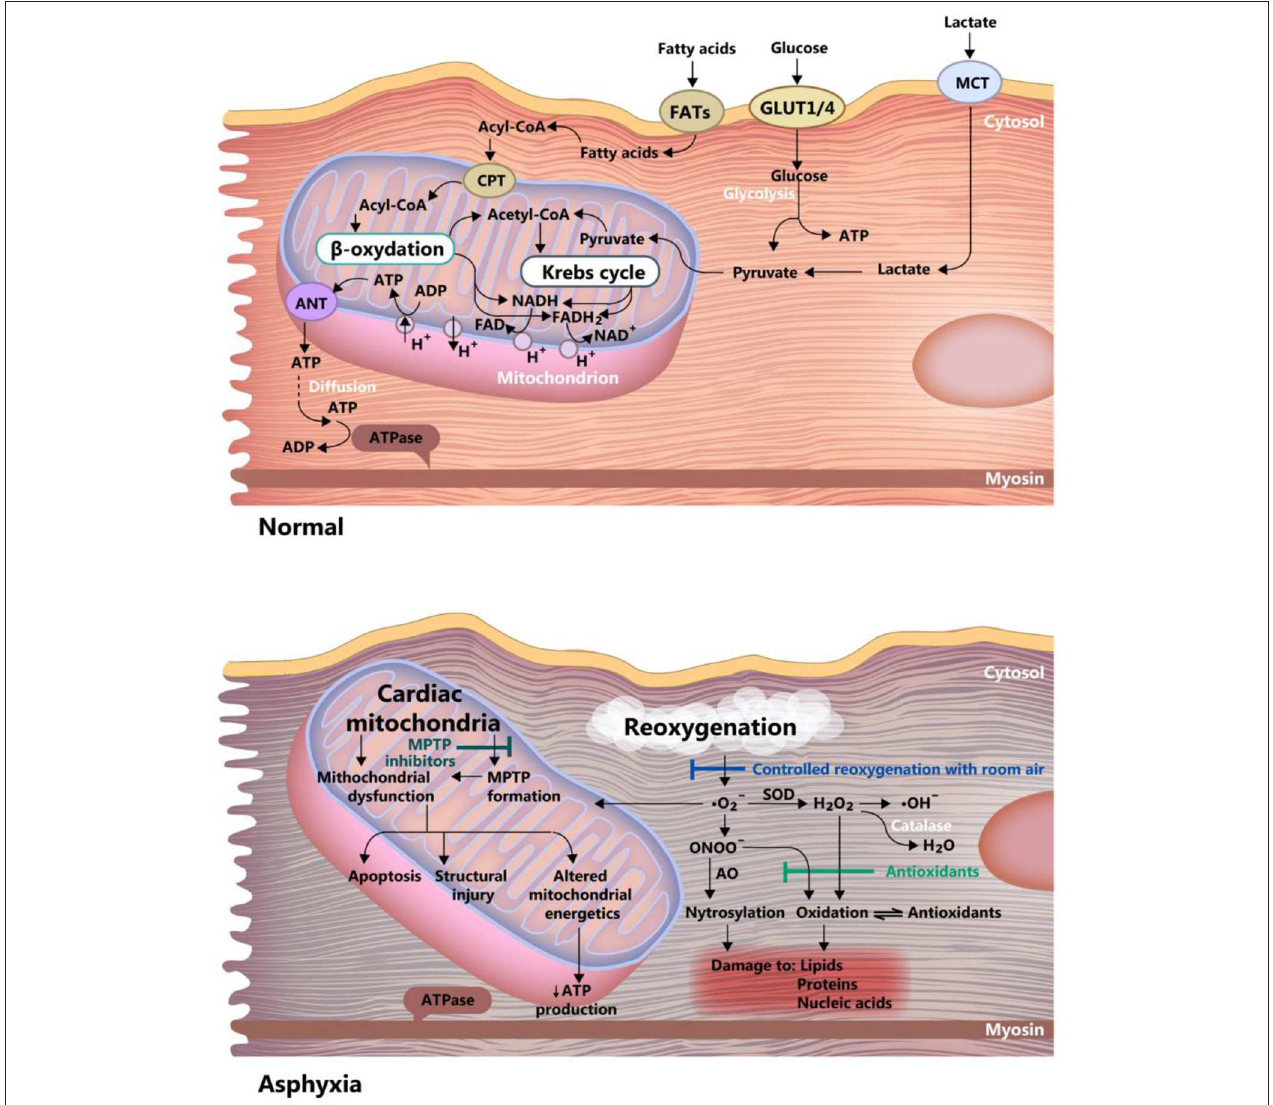
FIGURE 4 | Differences between asphyxia and normoxia in the newborn myocardium cell. Acetyl-CoA, acetyl-coenzyme A; Acyl-CoA, acyl-coenzyme A; ANT, adenine nucleotide translocase; FAD and FADH 2 , oxidized and reduced, flavin adenine dinucleotide; FATs, fatty acid transporter; GLUT ¼ , glucose transporter 1 and 4; MCT, monocarboxylate transporter; MPTP, mitochondrial permeability transition pore; ONOO, peroxynitrite; ATP, adenosine triphosphate; ADP, adenosine diphosphate; NAD and NADH, oxidized and reduced nicotinamide adenine dinucleotide, SOD, superoxide dismutase.